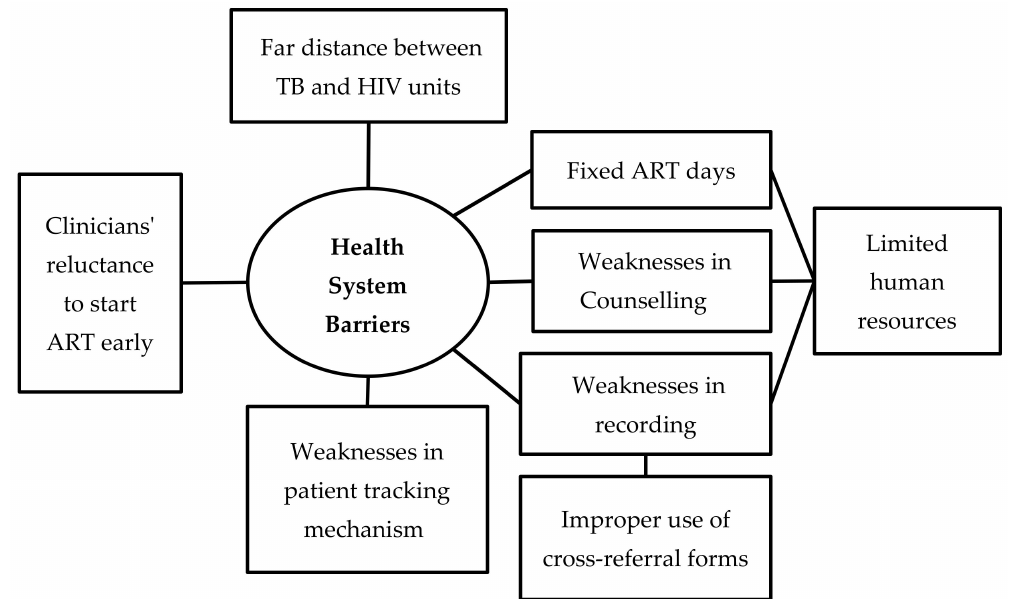
Figure 3. Non-hierarchical thematic map showing health system barriers in uptake of antiretroviral therapy among HIV-infected tuberculosis patients registered in the public health facilities of Ayeyawady Region of Myanmar, between July 2017 and June